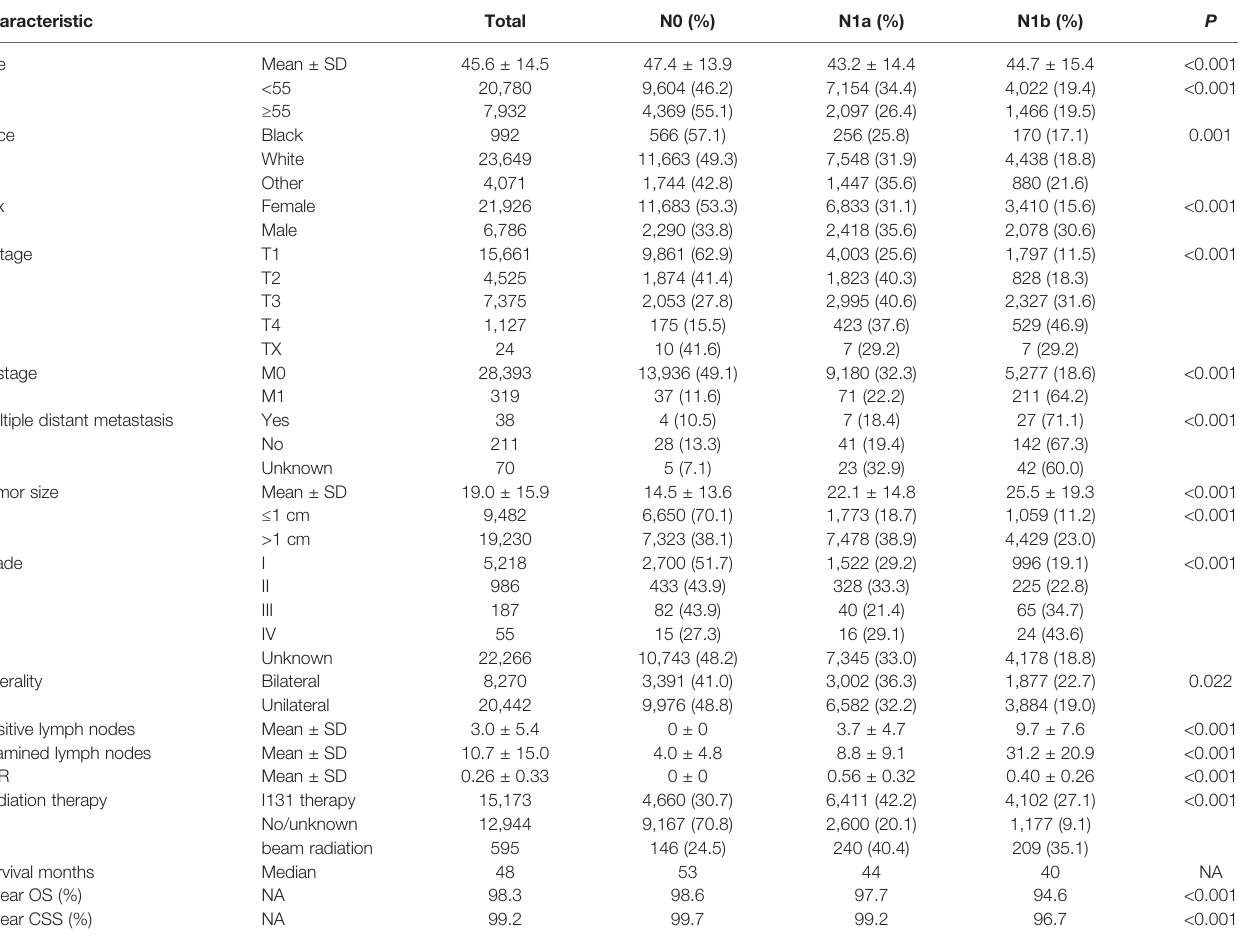
TABLE 1 | Baseline clinical and pathologic characteristics of patients.